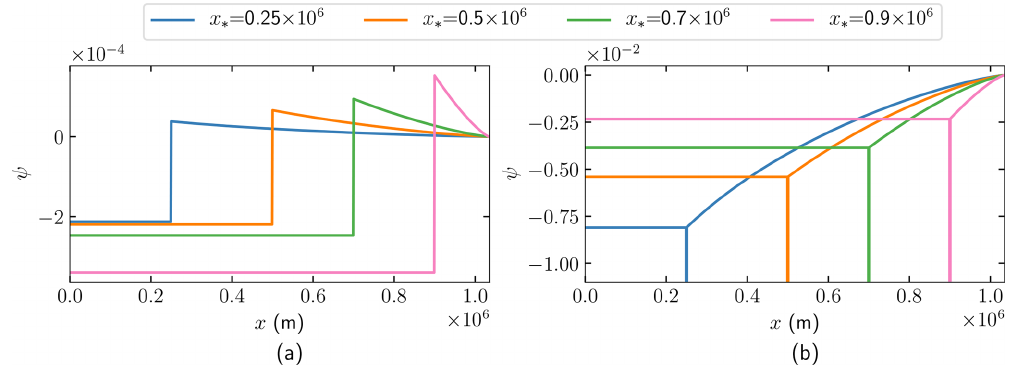
Figure 4. The analytical solutions of ψ in (40) of the observations of (a) u and (b) h at different locations x ∗ = 0 . 25 × 10 6 , 0 . 5 × 10 6 , 0 . 7 × 10 6 , and 0 . 9 × 10 6 m.